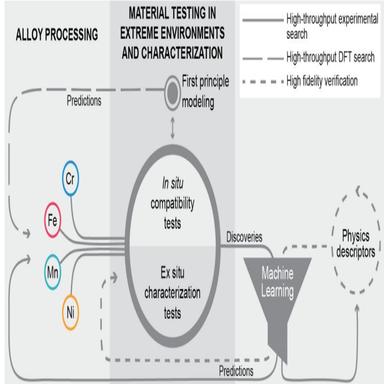
Schematic describing the integrated approach toward the overall goal of new alloy development for high-temperature nuclear structural materials applications.